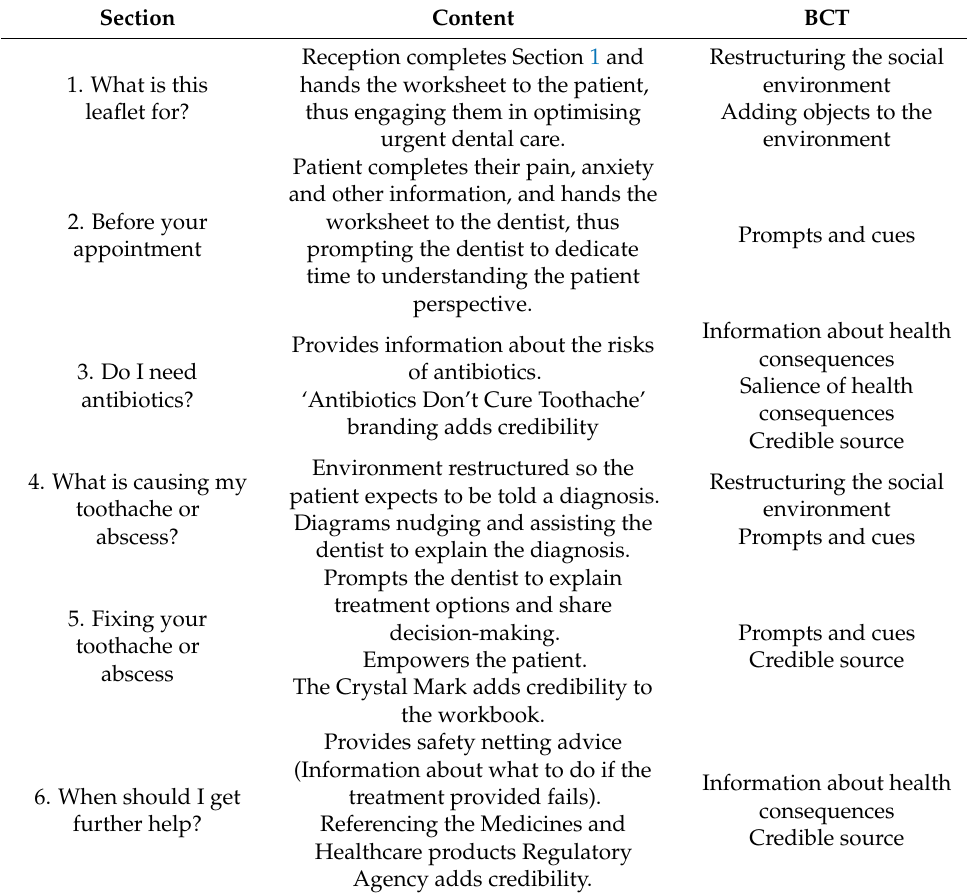
Table 3. Details of the content and behaviour change techniques (BCTs) within each section of the shared decision-making, dental antibiotic stewardship